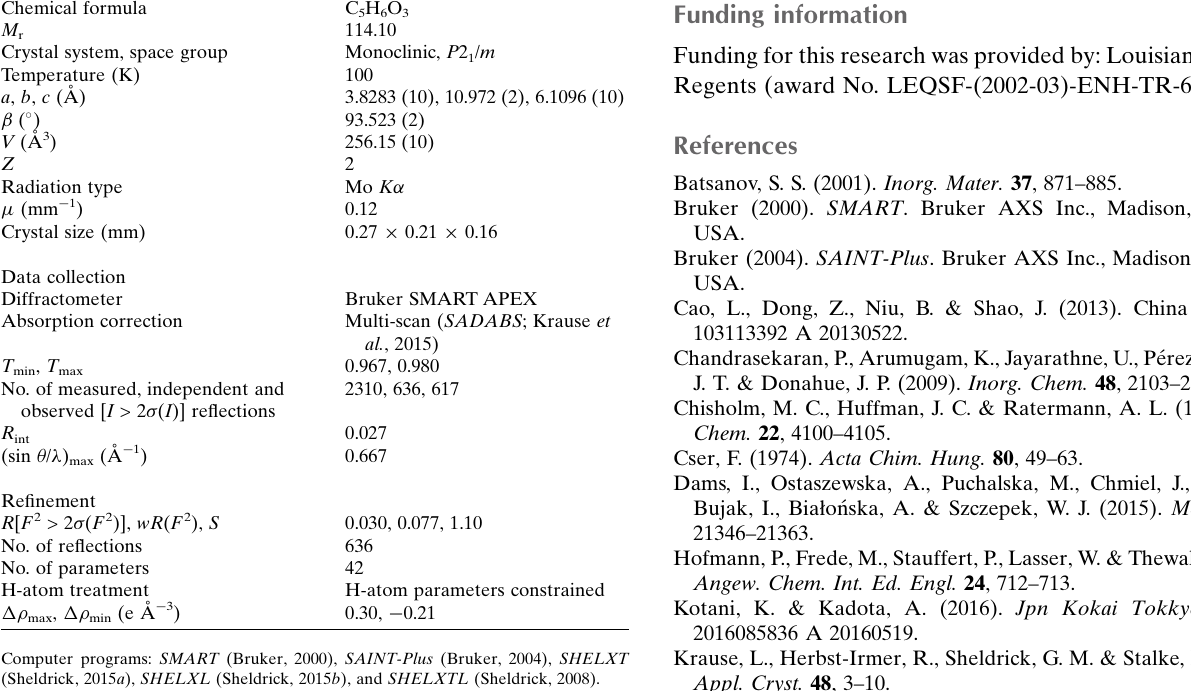
Table 2 Experimental details. Crystal data Chemical